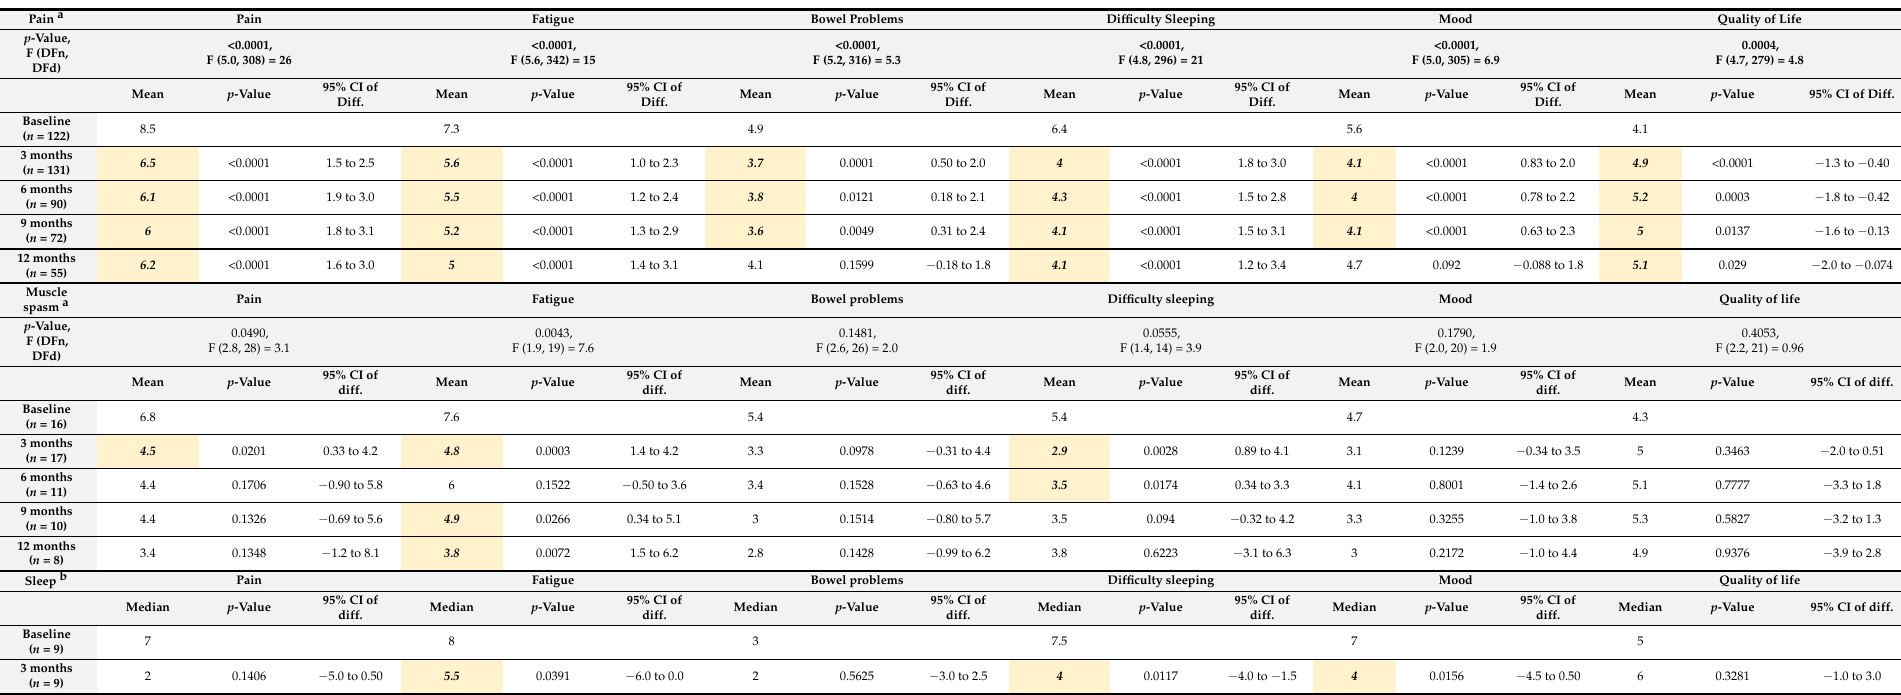
Table 4. Symptom assessment scale scores for patients with the indication: (a) pain; (b) muscle spasm; (c)